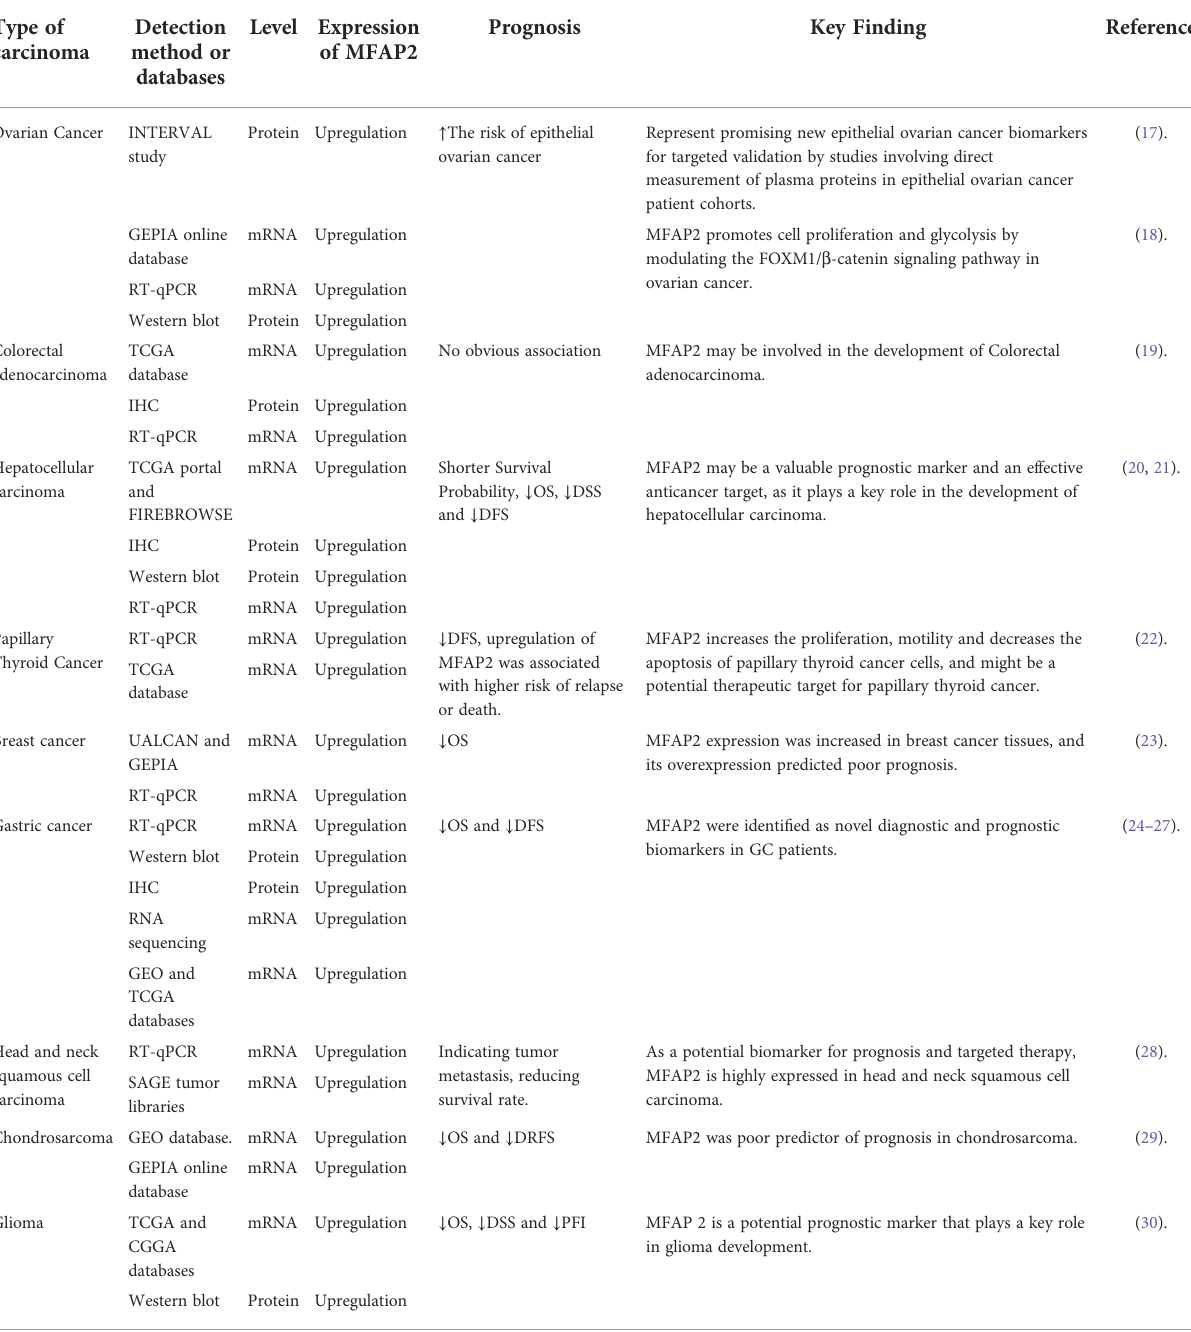
TABLE 1 MFAP2 expression and its effects on prognosis in different types of